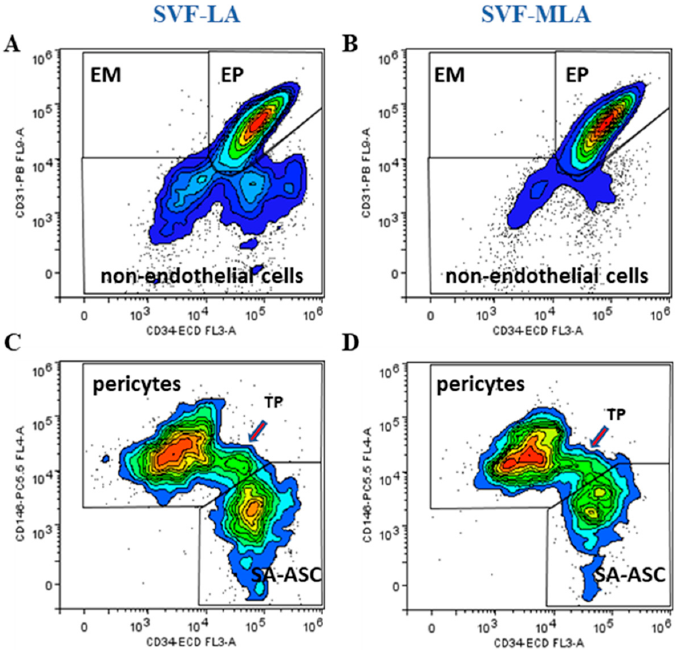
Figure 2. Nucleated CD45 - live cells were analyzed for the presence of the CD31 and CD34 lineage specific surface markers. Endothelial mature (EM), endothelial progenitor (EP) and non-endothelial cells were identified as CD31 + CD34 - , CD31 + CD34 + and CD31 - CD34 - cells, respectively ( A,B ). Non-endothelial cells were analyzed further for CD146 expression in combination with CD34 to discern pericytes, transitional pericytes (TP) and supra-adventitial-adipose stromal cells (SA-ASC) in SVF-LA and SVF-MLA samples ( C,D ).